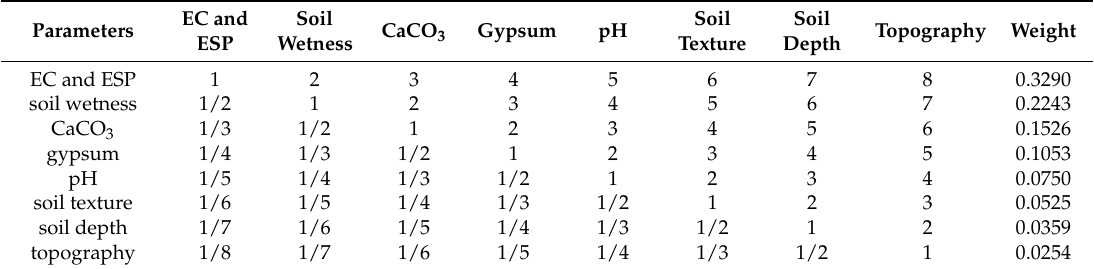
Table 3. Pairwise comparison matrix for land suitability for